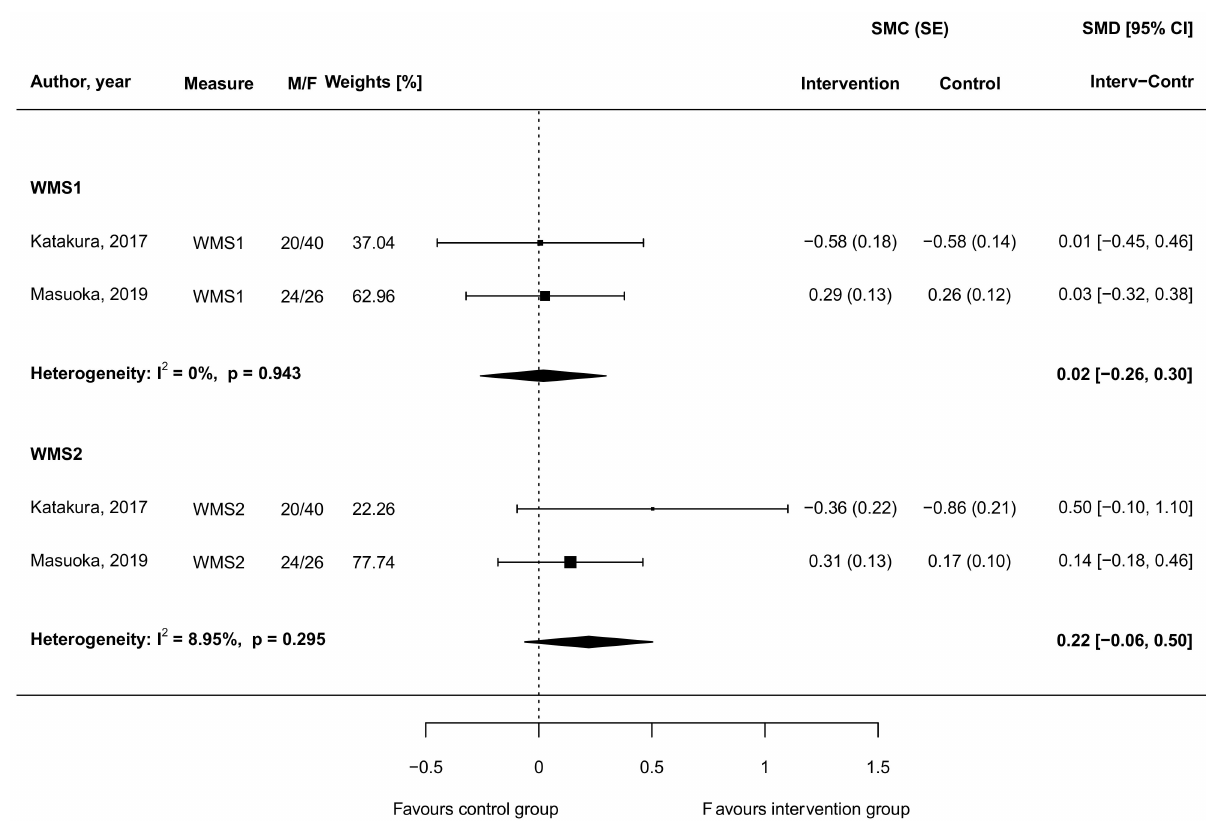
Figure 4. Standardized mean differences in verbal memory outputs between intervention groups supplemented with carnosine and control groups in randomized controlled trials. Abbreviations: CI (confidence interval), F (female), M (male), SE (standard error), SMC (standardized mean change), SMD (standardized mean difference), WMS (Wechsler Memory